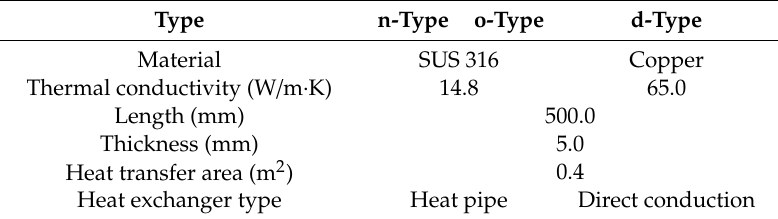
Figure 4. Geometry of the waste heat exchanger absorber plate. ( a ) n-Type; ( b ) o-Type; ( c ) d-Type. Table 3. Specifications of heat exchanger model.